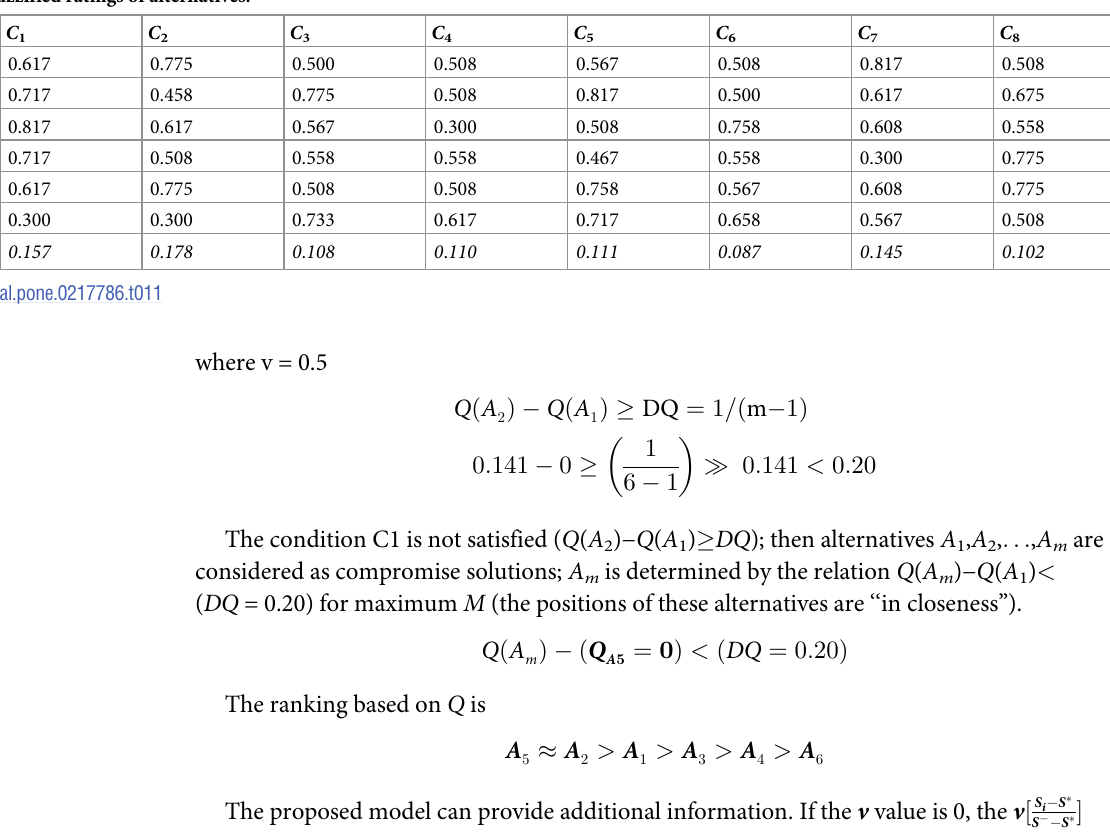
Table 12. Positive ideal solutions f �